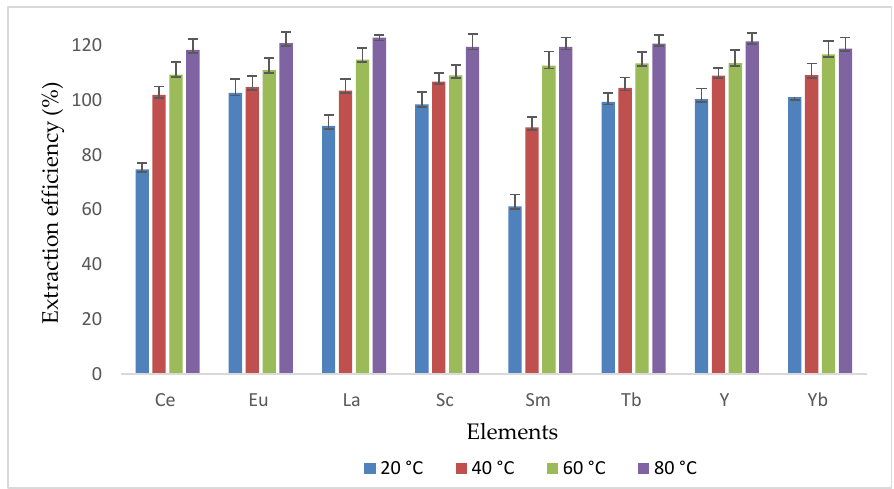
Figure 4. Effects of different ultrasound extraction temperatures (20, 40, 60, and 80 °C) for the extraction of REEs in coal samples. UAE conditions: [HNO 3 ] (1 mol L −1 ), sample mass (0.1 g), extraction time (20 min), UAE temperature (optimized), UAE frequency (high), and replicates ( n = 3).